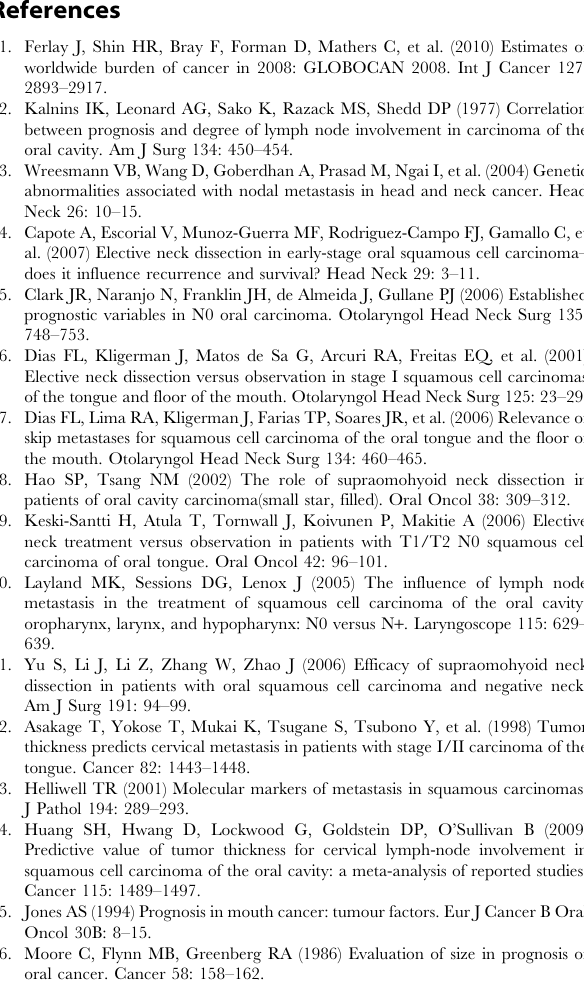
Table S4 Comparison of CNAs between MPT and LNM. Table S5 Comparison of CNAs between NMPT and LNM. Table S6 Sample IDs and summarized aberrations of publicly deposited data from